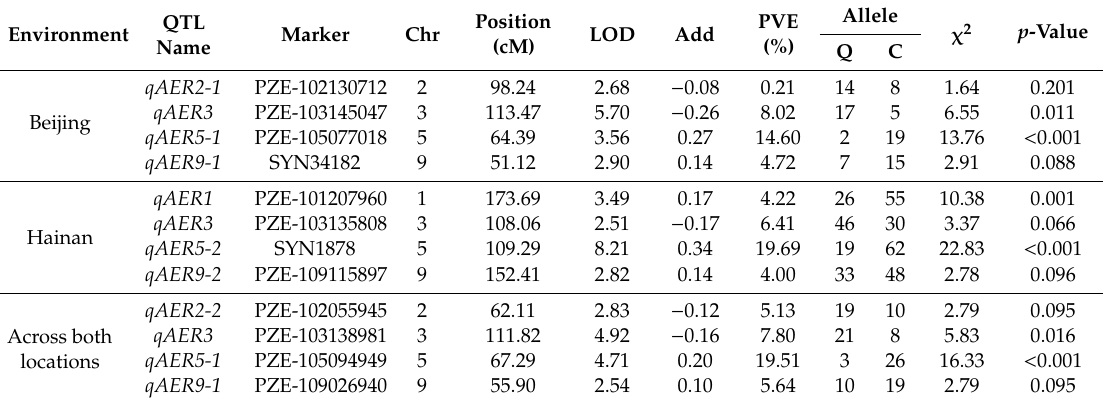
Table 1. Putative QTL detected for AER in the haploid mapping population. Environment